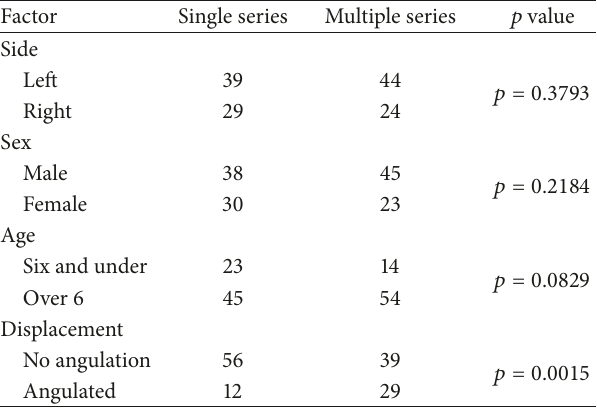
Table 3: Correlation of factors related to a patient receiving multiple radiograph